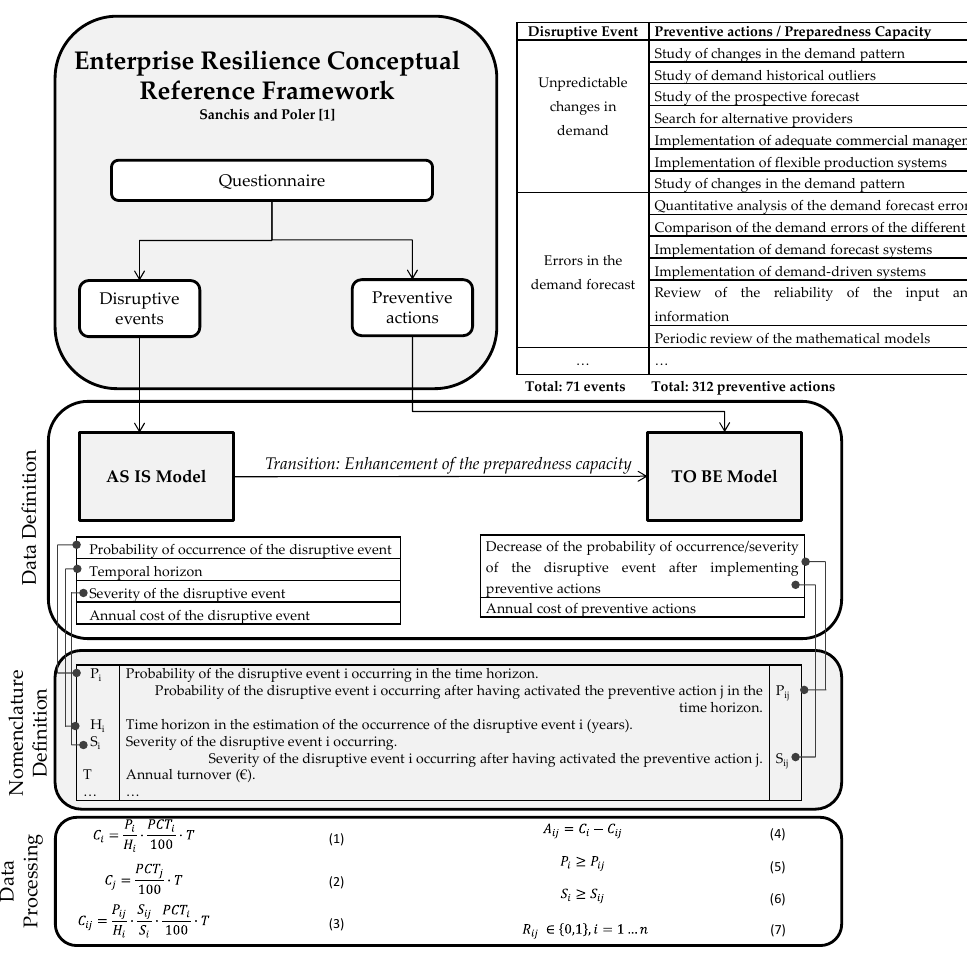
Figure 2. Data-modelling approach.